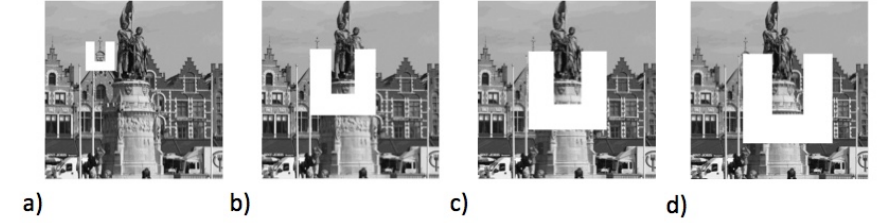
Figure 6. Content replacement attack: ( a ) 3.2%, ( b ) 10%, ( c ) 15%, and ( d ) 20%. Table 1. Self-recovery schemes’ performance in perceptual, robustness, and time complexity terms.